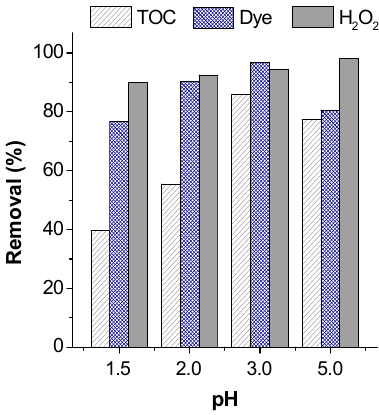
Figure 11. Removals of TOC and dye and hydrogen peroxide consumption, after 4 h of CWPO, with radiation, using Au / Al 2 O 3 as catalyst ([OII] = 0.1 mM, [H 2 O 2 ] initial = 6 mM, [catalyst] = 2.0 g / L, T = 30 ◦ C and I = 500 W / m 2 ). Adapted from Rodrigues et al. [110].